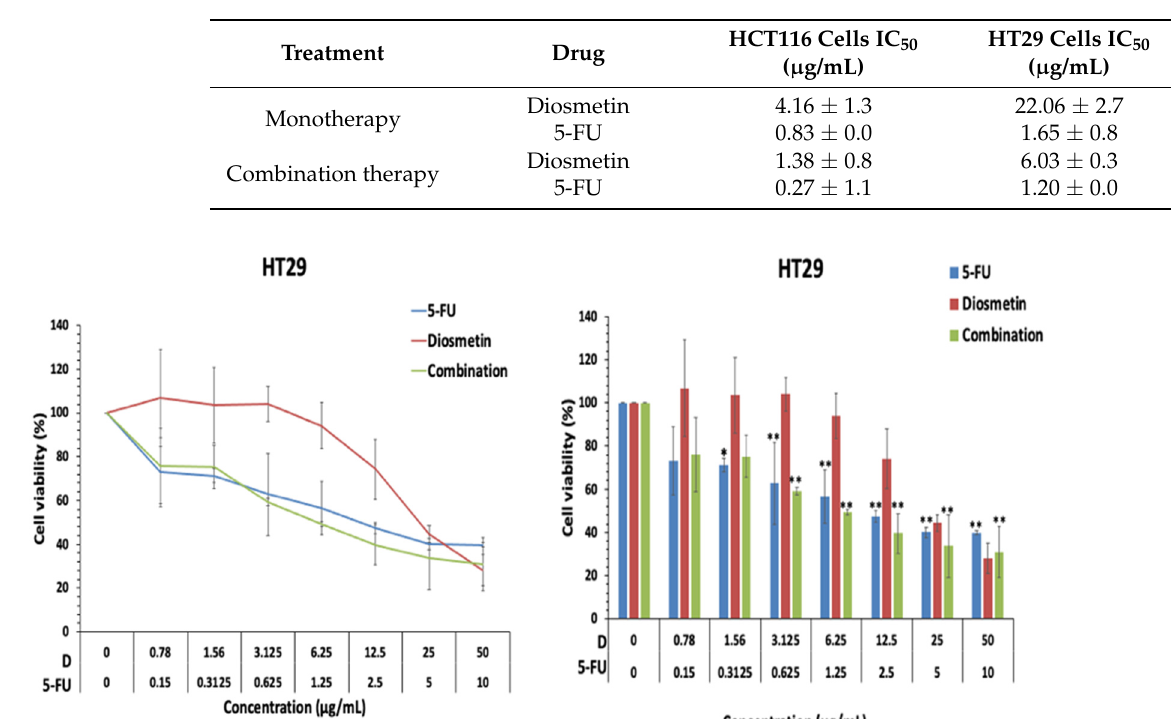
Figure 4. Cell growth inhibitory effect of diosmetin (D) and 5-FU as monotherapy and combination therapy in HT29 cells. Data were expressed as mean ± standard deviation (SD). * p < 0.05 and ** p < 0.01 indicate significant differences compared with the untreated control (0).